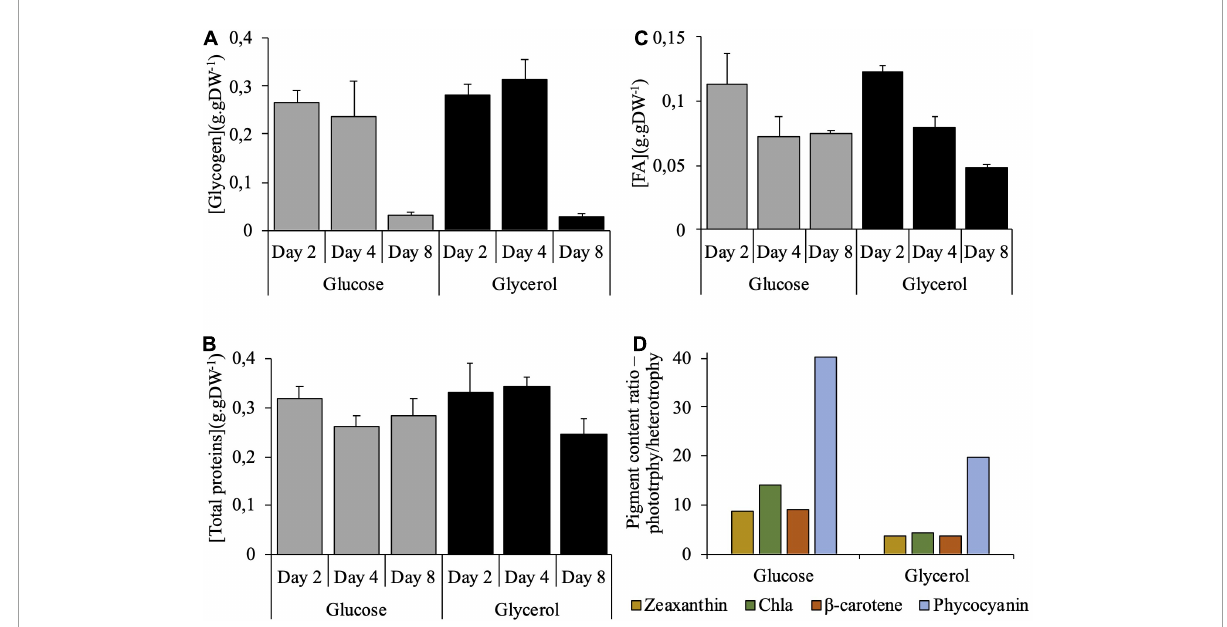
FIGURE2 Biomass composition of Galdieria sulphuraria cells grown in heterotrophy in the presence of glucose or glycerol. Glucose (gray bars) or glycerol (black bars). Graphs (A–C) show the total glycogen, proteins, and fatty acids content expressed in g.g DW − 1 , respectively. Day 2: exponential phase; Day 4: early stationary phase; Day 8: late stationary phase (last day of culture). Data are presented as means of three independent biological replicates. Error bars represent standard deviation ( ± SD). Bar chart (D) shows the phototrophy to heterotrophy (glucose or glycerol as substrate) pigment content ratio in exponential phase (Day 2). Pigments shown for each data series are, from left to right, zeaxanthin, chlorophyll a (Chla), β -carotene, and phycocyanin. Data are presented as the mean from three independent biological replicates